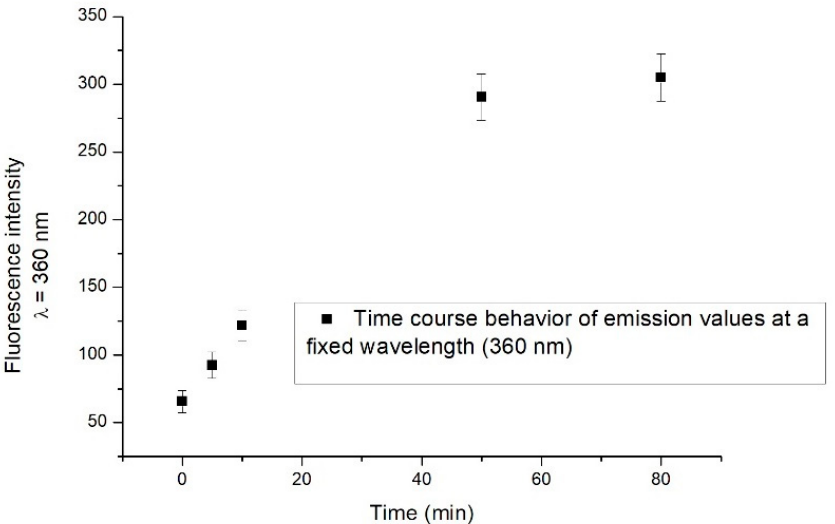
Figure 3. Emission spectrum of a solution of laccase and catechol ([laccase] = 8 μ g/mL and [catechol] = 0.4 mM). Measurements were performed at various times: immediately after catechol addition (t0) (black line), 5 min (red line), 10 min (green line), 50 min (blue line), and 80 min (purple line) after catechol addition.